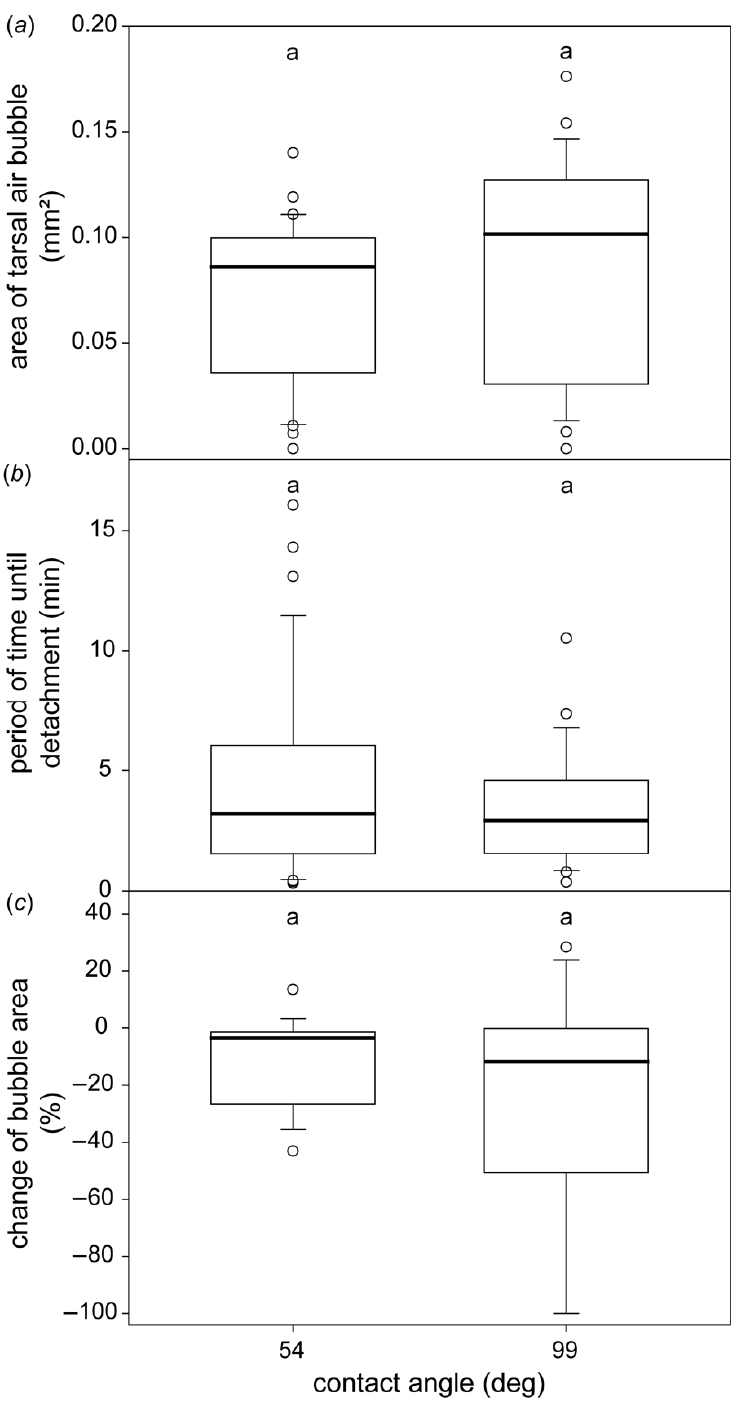
Figure 4. The subtarsal air bubble on different surfaces. Area of the tarsal air bubble taken immediately after G. nymphaeae was submerged on hydrophilic and hydrophobic glass slides (a), time until beetle detachment (b), and difference of the bubble area between the beginning of the experiment and just before the beetle detached (c). The plots show the medians (lines within the boxes), 25th and 75th percentiles (ends of boxes), 10th and 90th percentiles (error bars) and outlying values (circles). The same letter above the two boxes in each experiment indicates no significant differences between the two groups. Sample size: 1–3 different randomly chosen legs of 21 beetles; upper and middle plot: n = 34 and n = 28, lower plot: n = 19 and n = 17 for the 54° and 99° surfaces, respectively. Same letters (a, a) within each subplot indicate absence of statistically significant difference between samples.